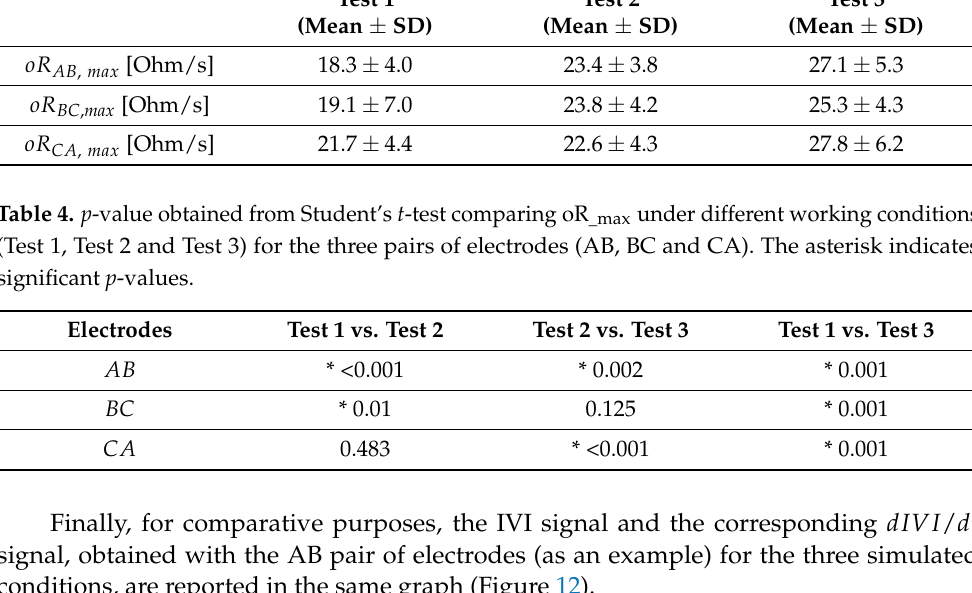
Figure 11. The IVI signal (black line) and the corresponding first derivative dIVI/dt (green line) obtained for the three pairs of electrodes during Test 3 (cycle rate 50 bpm, stroke volume 80 mL). AB ( left ), BC ( center ) and CA ( right ). O = start of valve opening identified with the low peak of the aortic pressure.